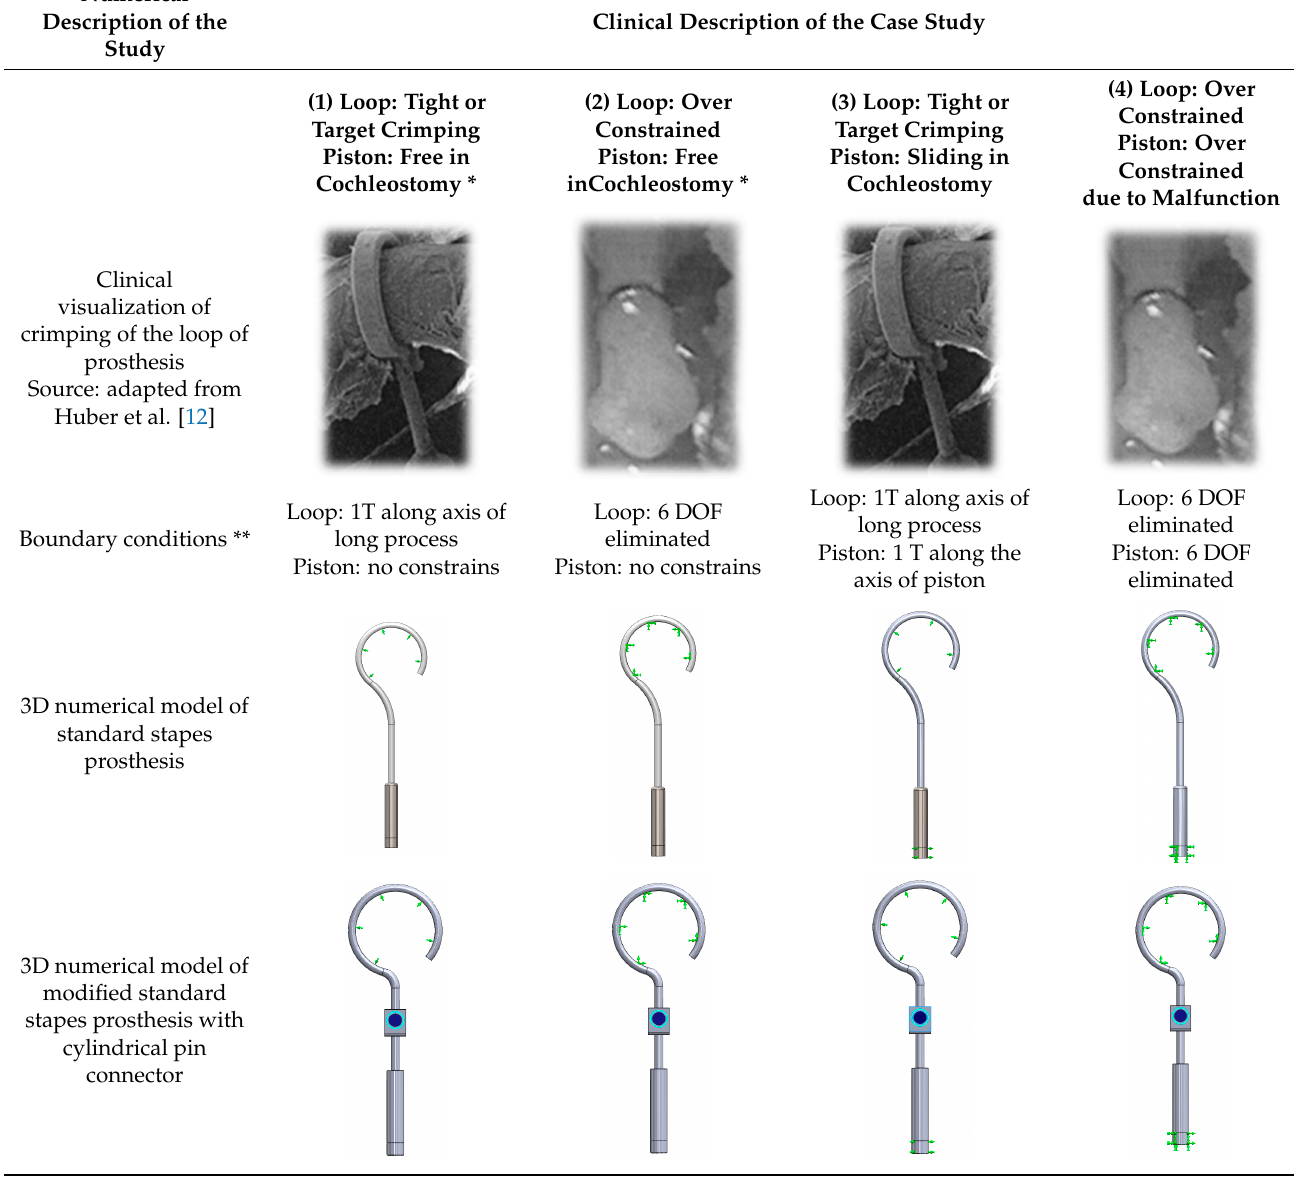
Table 1. The setup of stapes prosthesis constraining and boundary conditions for eigenfrequency analysis.